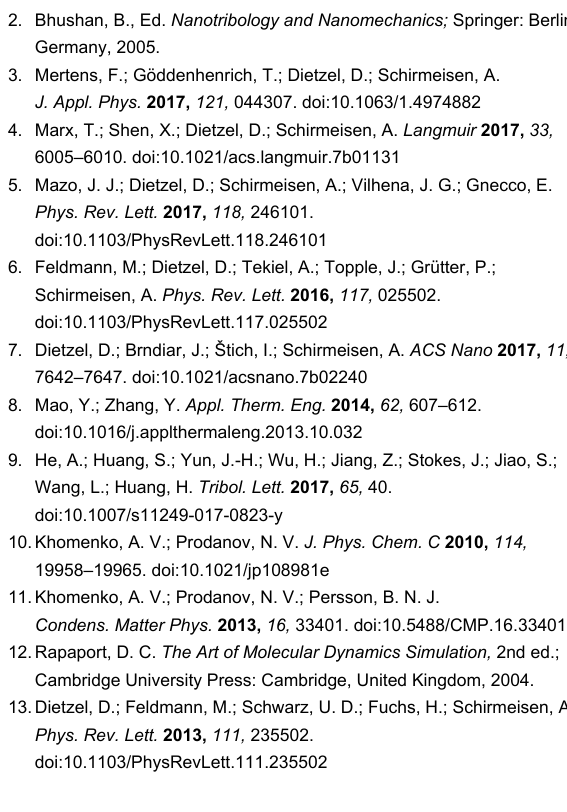
Figure 10: (A, C) Side and (B, D) bottom views of (A, B) Al and (C, D) Pd nanoparticles containing 20000 atoms at a temperature of 300 K. Nanois- lands with local order are outlined by yellow contours.